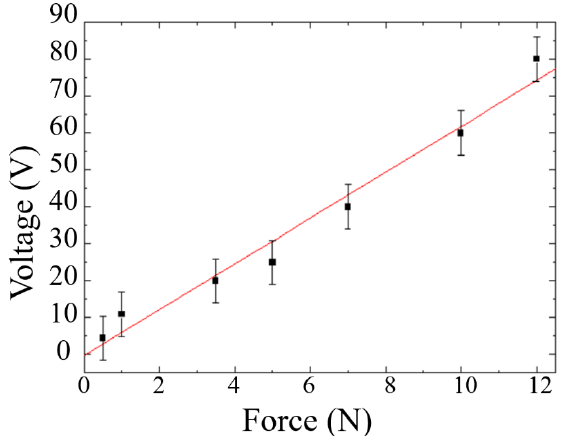
Figure 9. The output voltage of MN-FTENG under various forces, the slope of the sensitivity is 7 V/N, which is significantly higher than other Mechanical energy harvester. Additionally, the coefficient of determination of this experiment is 0.97, which shows high reliability of MN-FTENG’s force sensitivity. The force comes from the weight dropping from a specified height (3 cm, 5 cm, 7 cm, and 10 cm) and is measured by the load cell. The same force acts on MN-FTENG and the output voltage is measured by HIOKI. The measured force range is 0.5 N to 10 N, and the voltage range is 5 V to 80 V. Table 2. Comparison of fiber-based MN-TENG with fiber EMG and PENG.